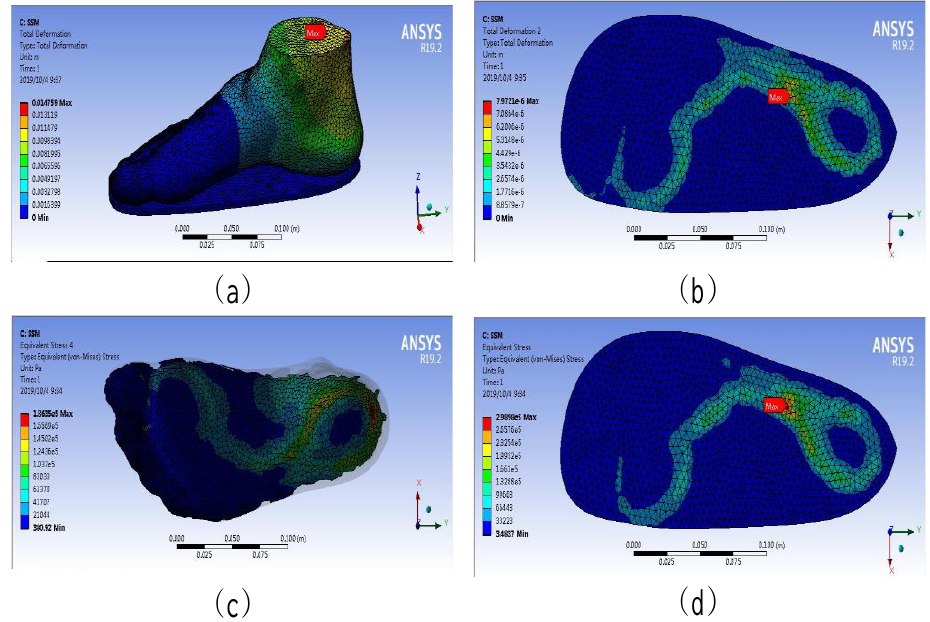
Figure 7. Plantar pressure distribution obtained from SSM under 300 N loading. ( a ) model’s total deformation, ( b ) insole deformation, ( c ) plantar pressures, ( d ) insole stresses.